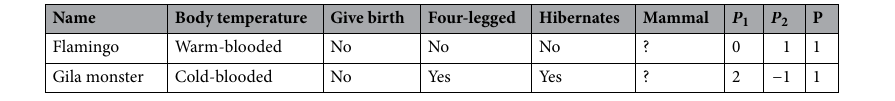
Table 4. Prediction of class